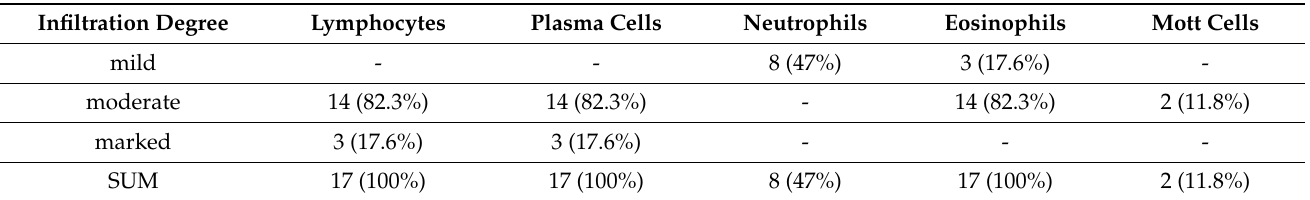
Table 3. Table showing the type of cellular infiltration in the lamina propria of the rectum, along with its degree, number of horses ( n = 17), and % distribution in the studied horse population.